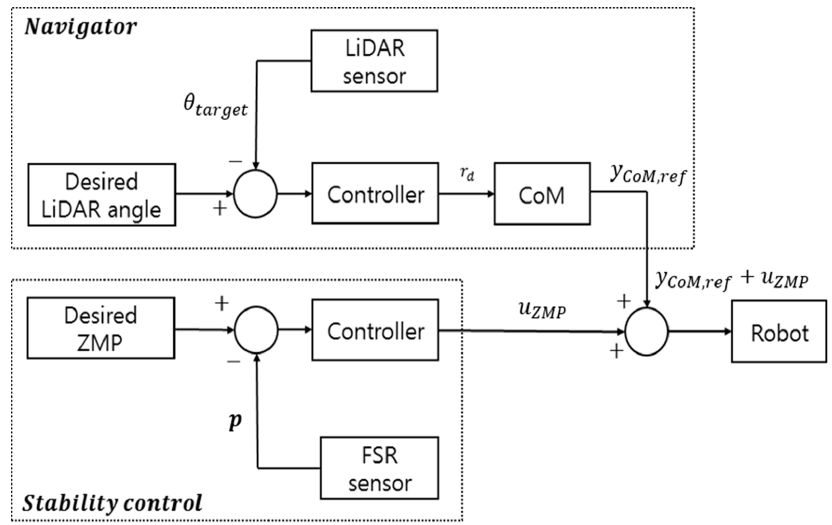
Figure 7. Overall navigation and stability control method of a skiing robot.